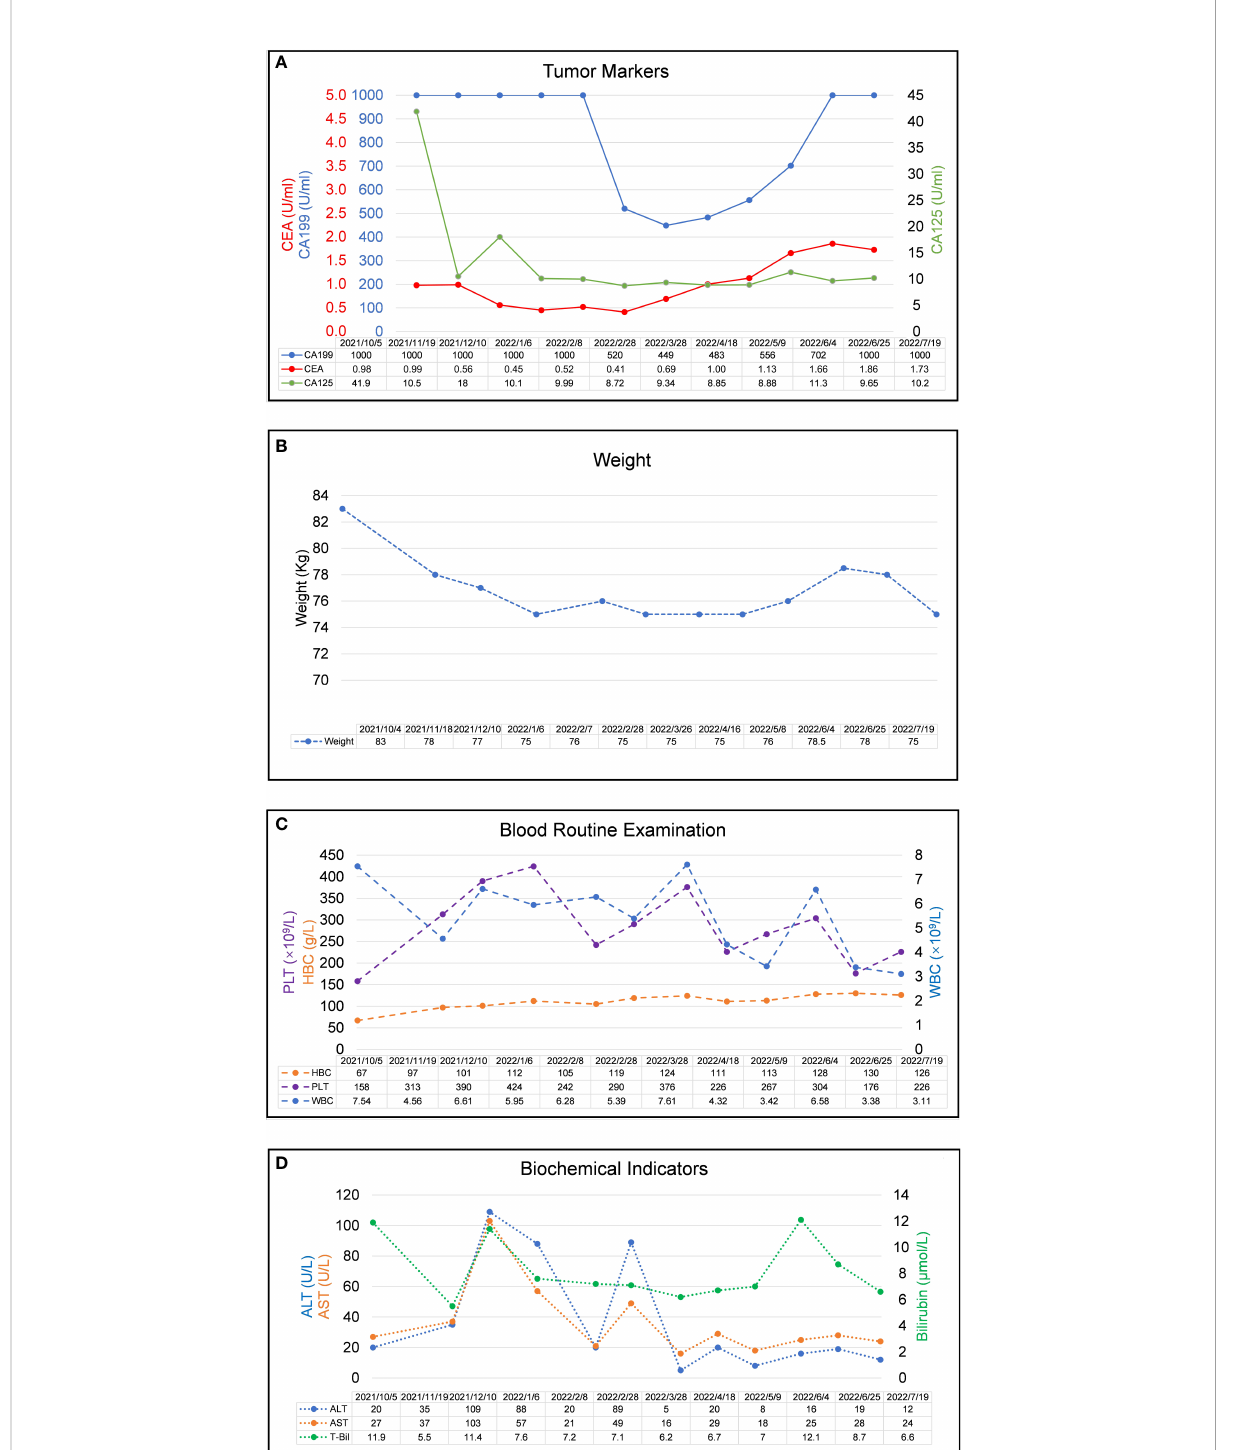
FIGURE 3 Laboratory examination results during the clinical course. (A) Trends in the level of tumor markers, including CA 199, CA125, and CEA (right Y- axis) correspond to the treatment timeline. (B) Trends in the level of weight changes corresponding to the treatment timeline. (C) . Trends in the level of blood routine examination, including PLT, HBC, and WBC (right Y-axis) correspond to the treatment timeline. (D) Trends in the level of biochemical indicators, including ALT, AST, and Bilirubin (right Y-axis) correspond to the treatment timeline. All X-axes show the date of disease progression. (CEA, carcinoembryonic antigen; CA199, carbohydrate antigen 19-9; CA125, carbohydrate antigen 125, WBC, white blood cell count; HBC, hemoglobin; PLT, blood platelet count, ALT, alanine aminotransferase; AST, aspartate